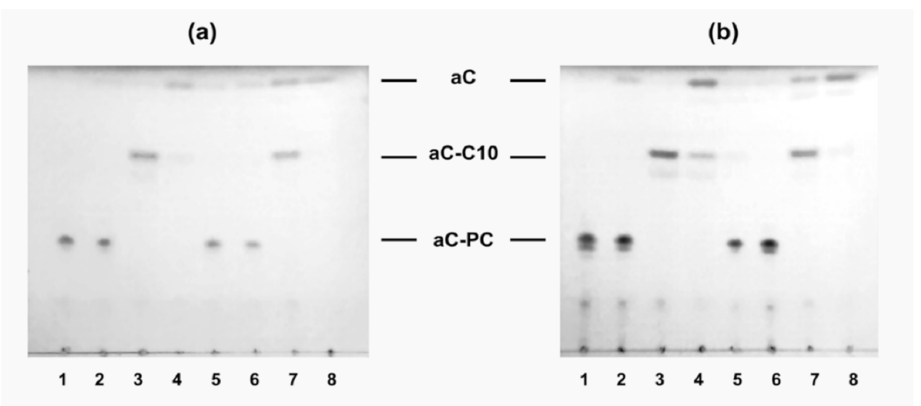
Figure 6. Thin layer chromatography of the L-aC-PC10 ( a ) and L-aC-PC25 ( b ) samples upon in- cubation in the absence of enzymes (tracks 1 and 5) and in the presence of porcine liver esterase (tracks 2 and 6), or phospholipase A2 (tracks 3 and 7), or both the esterase and phospholipase A2 (tracks 4 and 8) in Tris-HCl buffer, pH 8.25 (tracks 1–4) or 50% human plasma (tracks 5–8), at 37 ◦ C for 4 h. aC, free allocolchicinoid; aC-C10, fatty acid derivative of aC; aC-PC, phospholipid prodrug. UV detection. For sample designations, see Table